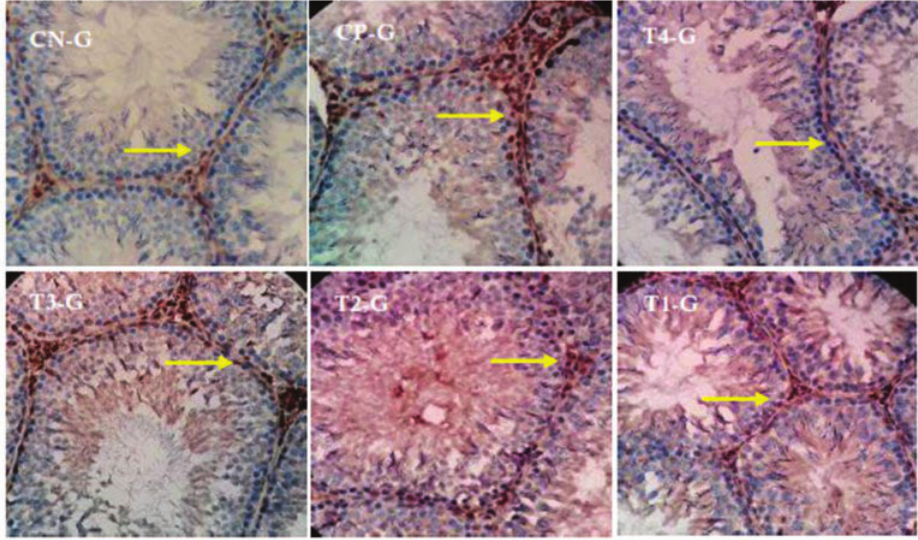
Figure 4. Histological preparation of caspase-3 expression in each group following treatment to the previous statement, there were also no significant difference in caspase-3 expressions between T4-G